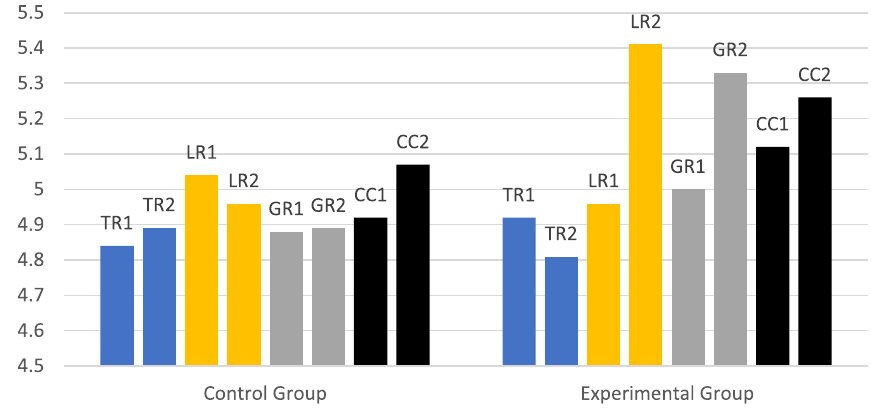
Fig. 5 Comparisons of scores in the four criteria. TR grammatical and accuracy, CC